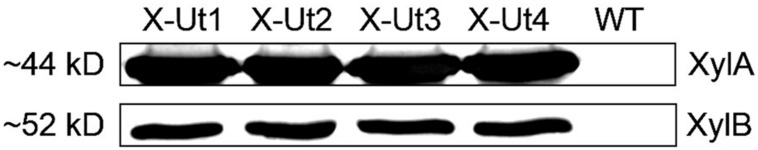
Immunodetection of xylose catabolic proteins. Protein samples extracted from Synechocystis transformant strains, X-Ut1, X-Ut2, X-Ut3, and X-Ut4 and the WT strain as the negative control were probed with specific polyclonal antibodies for the XylA (D-xylose isomerase) and XylB (D-xylulokinase) enzymes. Each lane was loaded with 20 μg of total protein fraction. The expected molecular masses for XylA and XylB proteins are indicated.